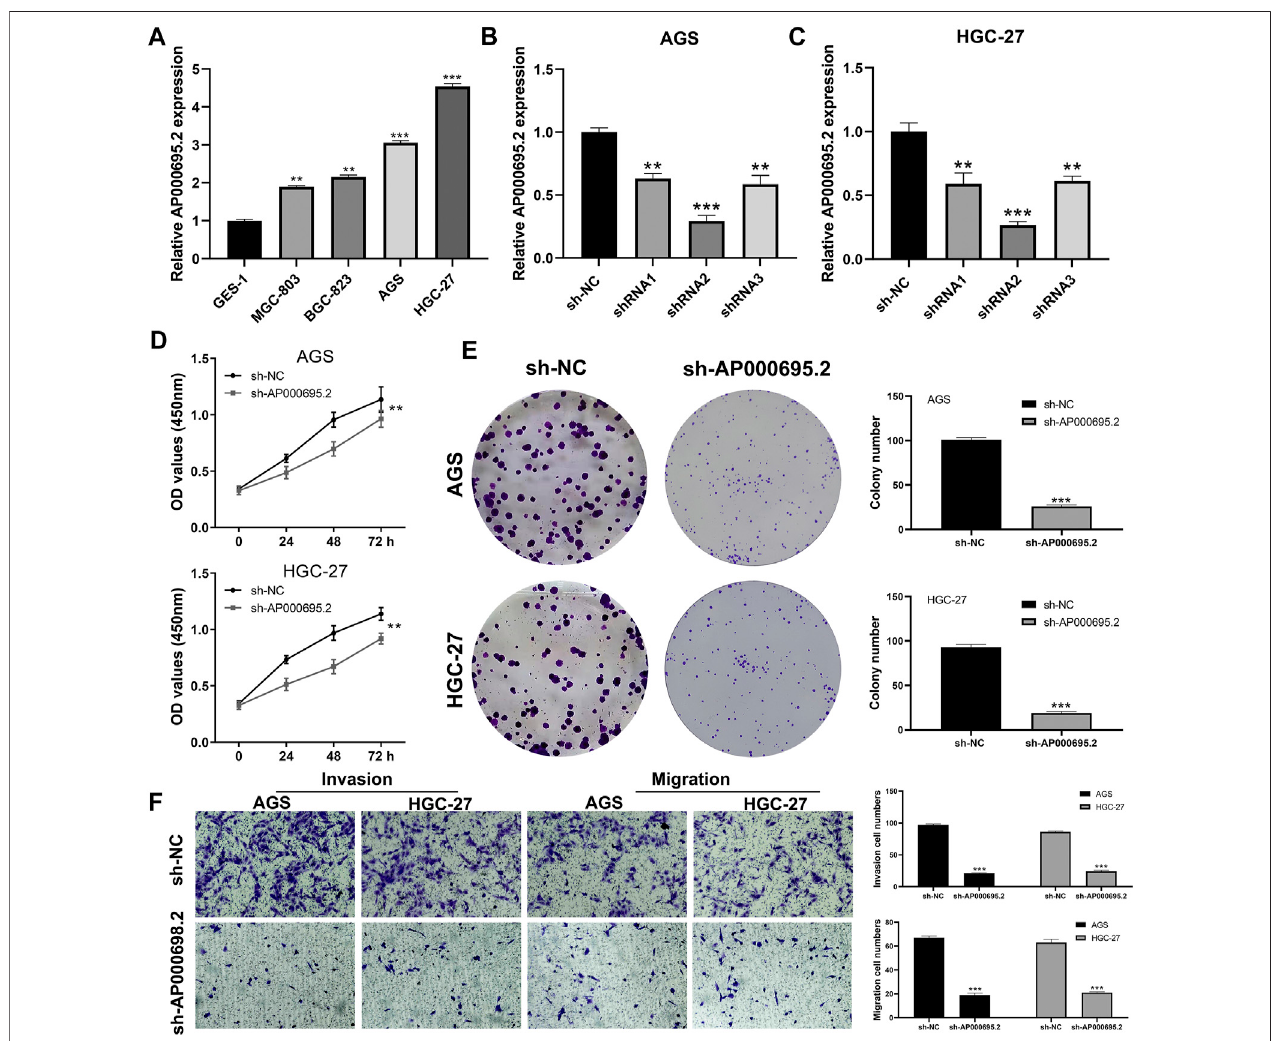
FIGURE 9 | AP000695.2 was selected for further in vitro experiments. (A) : AP000695.2 was upregulated in GC cells; (B,C) : qRT-PCR result showed an satisfactory knockdown ef fi ciency; (D,E) : CCK-8 and colony formation assays showed that the knockdown of AC000695.2 signi fi cantly inhibited GC cell proliferation; (F) : Transwell assay showed that the knockdown of AC000695.2 signi fi cantly inhibited GC cell invasion and